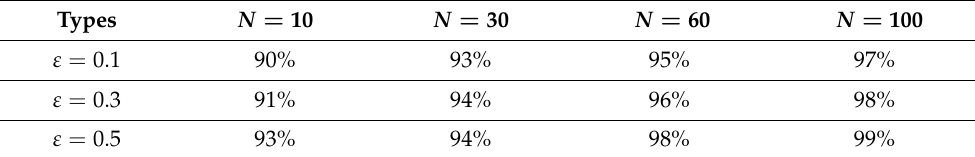
Table 1. Summary of coverage rates for x 0 with different ε and N .